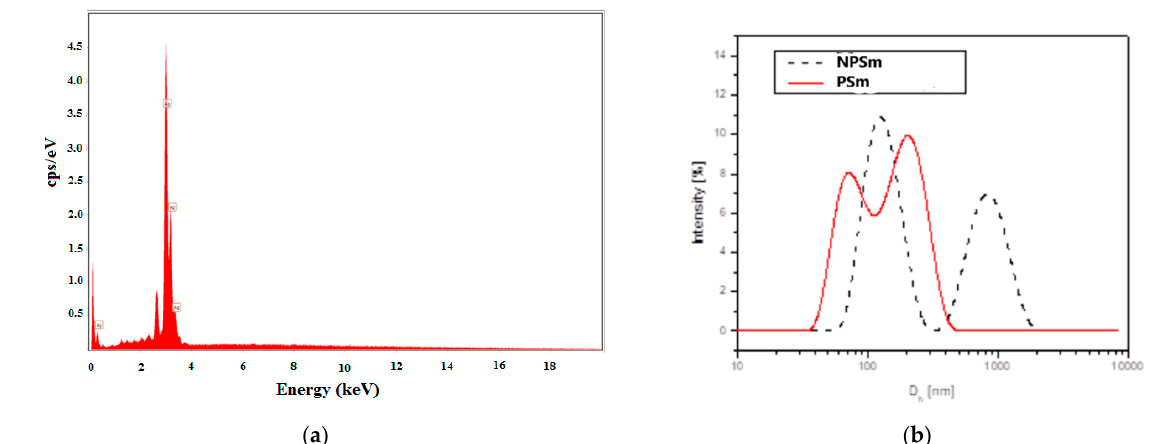
Figure 3. EDX spectrum for the mixture of AgNPs + CsSm extract (PSm) ( a ) and DLS hydrodinamic diameter distribution by intensity pattern ( b ) for the biosynthesized silver nanoparticles NPSm with a dotted line, and for the mixtureAgNPs + CsSm extract (PSM) with a red line.